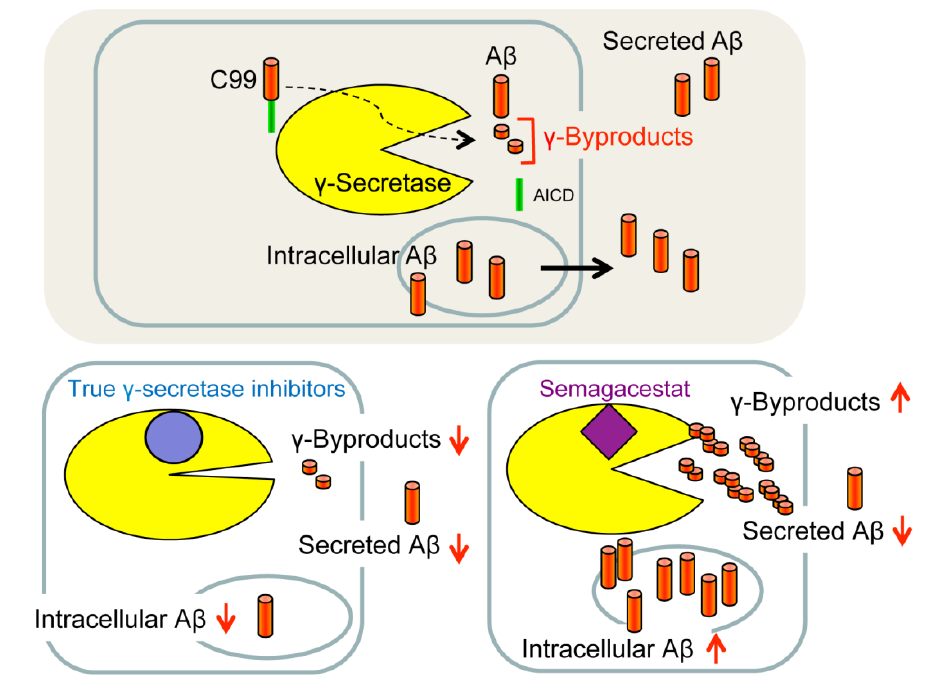
FIGURE 8: Pseudoinhibiton of γ -secretase by semaga- cestat. Cleavage of C99 by γ